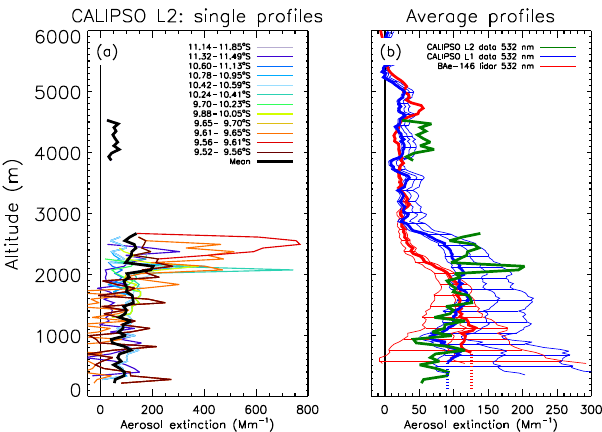
Figure 4. Profiles of aerosol extinction coefficient derived by li- dar: (a) Individual vertical profiles given in the CALIPSO Level 2 data set. Thick black line: average profile for the latitude interval sampled by the aircraft; (b) Green line: average extinction profile from the CALIPSO Level 2 data, for the latitude interval sampled by the aircraft; blue lines: profiles derived from the CALIPSO Level 1 data set; red lines: profiles derived from the aircraft data set and converted to 532nm. The range of values indicated for the red and blue lines indicates the uncertainty due to the far end reference used for signal inversion, and the thick lines indicate the profiles con- strained with AERONET. Note: for the purpose of constraining to AERONET, the lidar profile is prolonged with the dotted line (con- stant extinction) below the reference